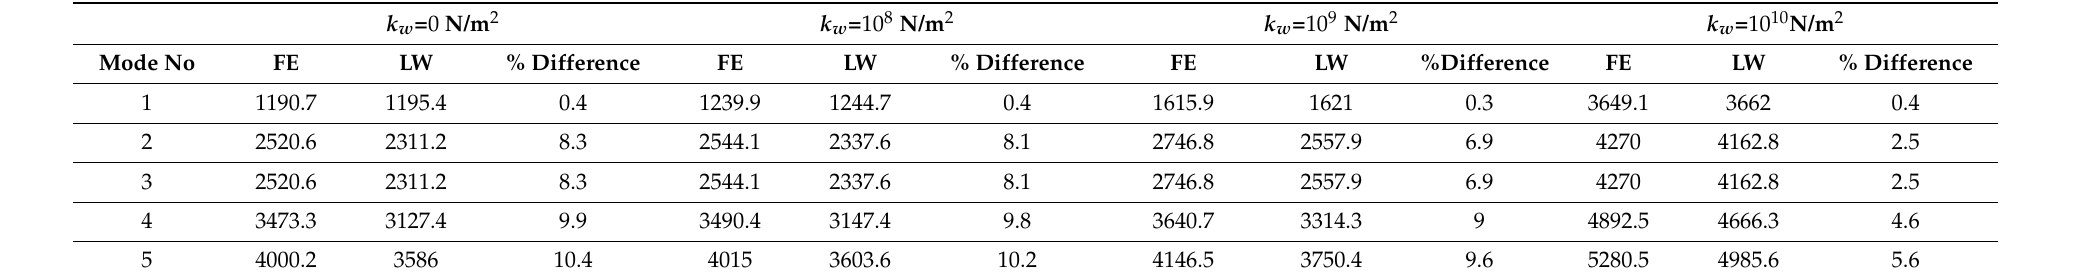
Table 10. Comparison of plate frequencies (HZ) based on the LT and those FE findings for different elastic foundations. n = 1, a h